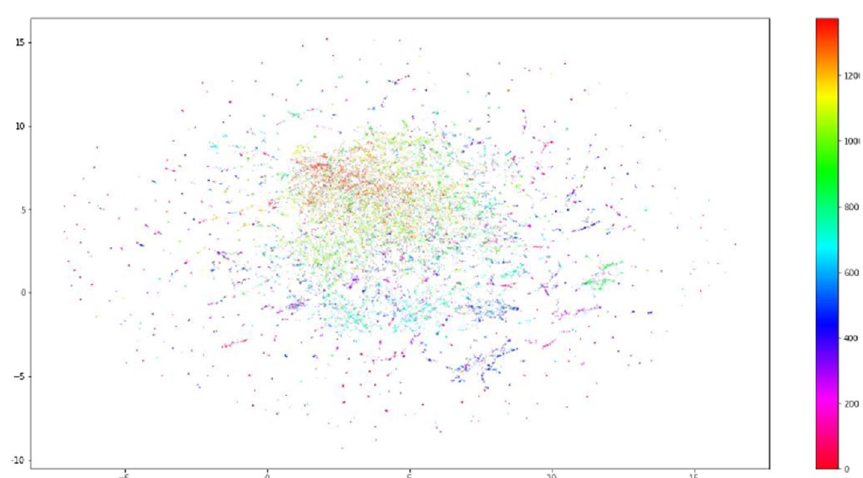
Fig. 6 Topic distribution of the training